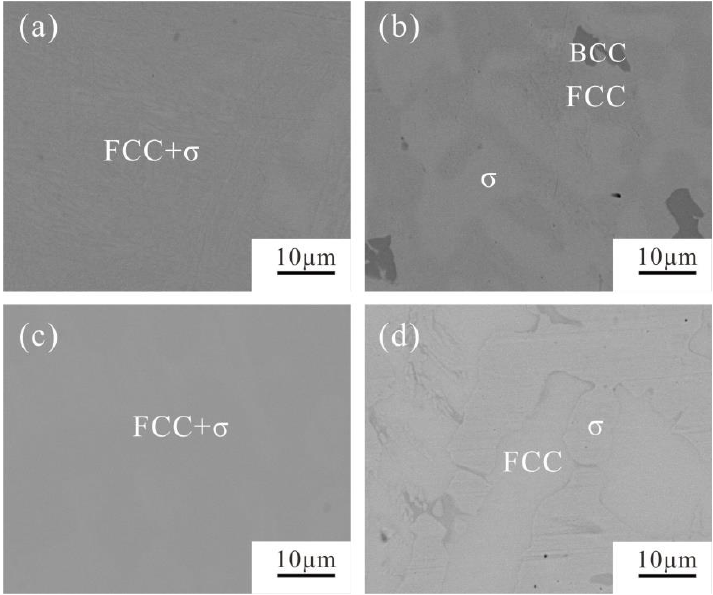
Figure 5. BSE micrographs of the alloys A4 (20Co40Cr30Fe10Ni) and A7 (20Co50Cr10Fe20Ni). ( a ) as-cast alloy A4, ( b ) 1000 annealed alloy A’ 4, ( c ) as-cast alloy A7, ( d ) 1000 annealed alloy A’ 7.